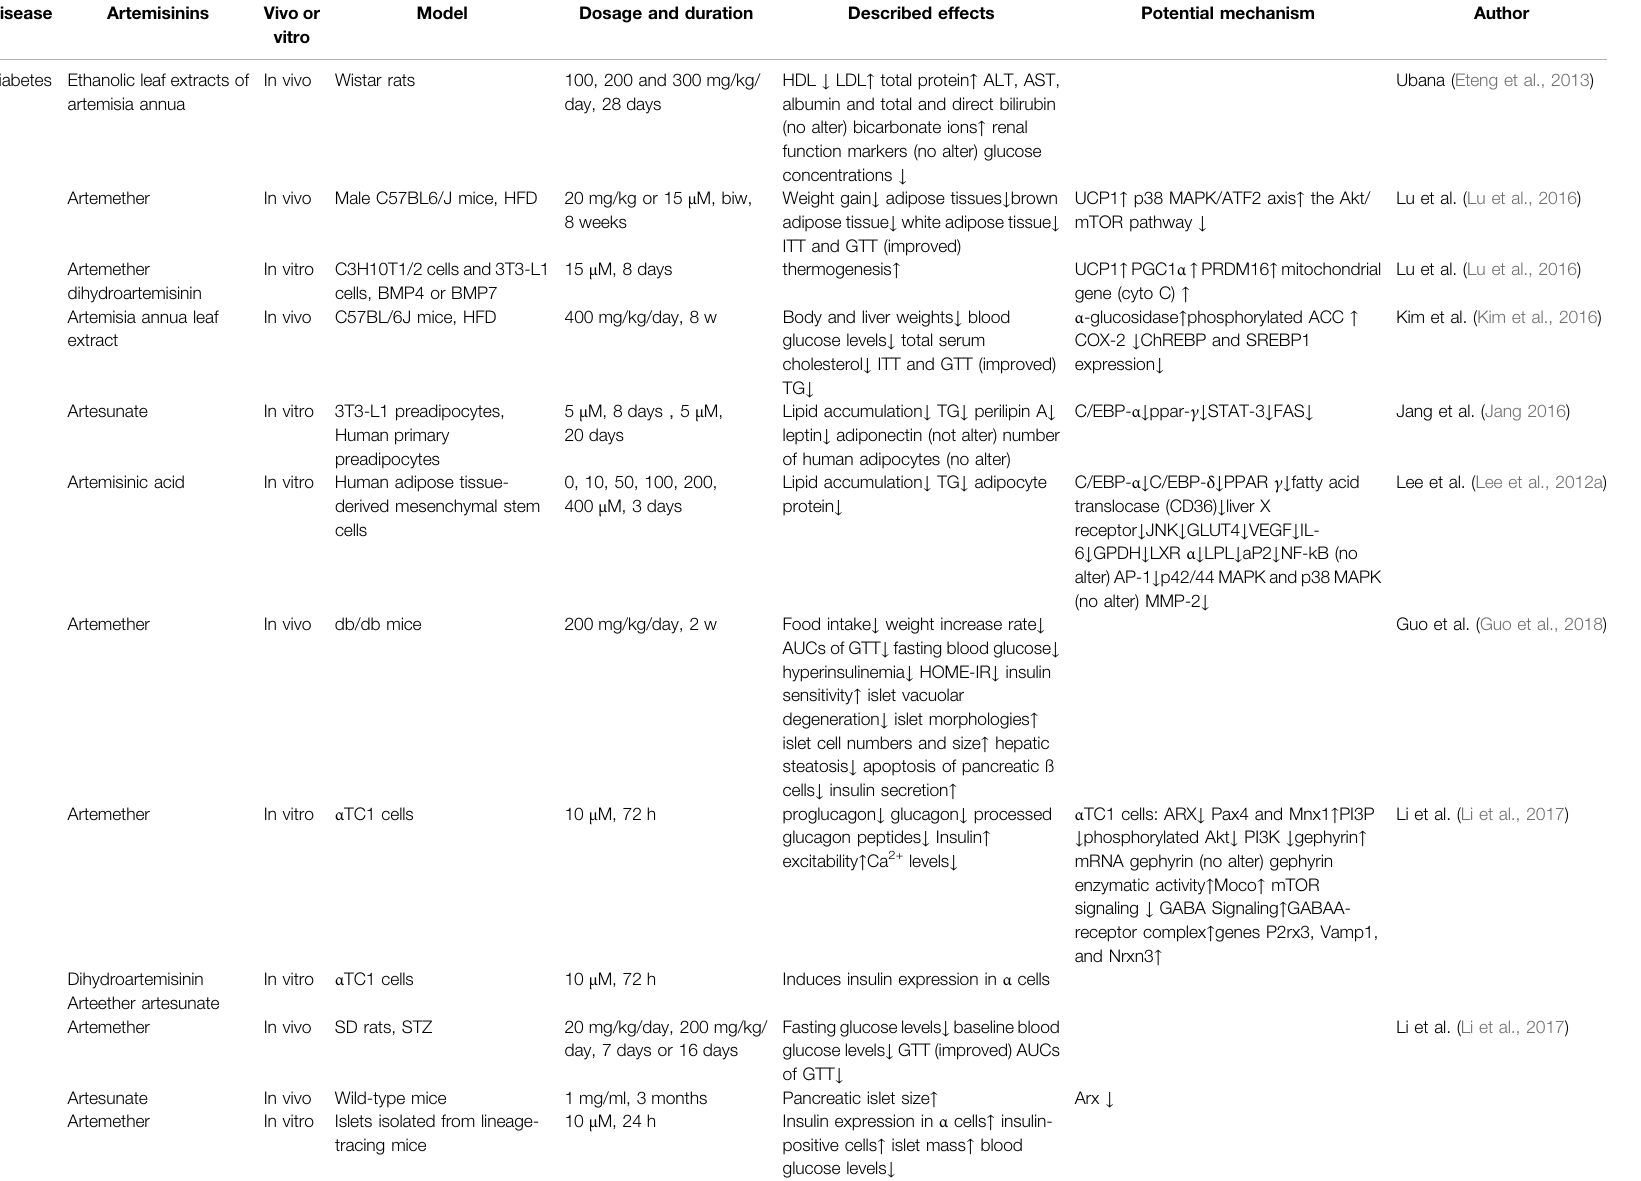
TABLE 1 | Effects of artemisinin and its derivatives on T2DM.